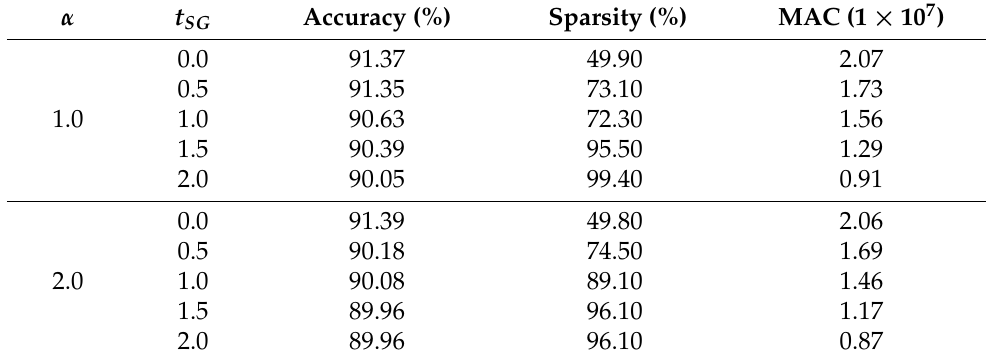
Table 7. Effectiveness of CSGN (SG) according to the hyperparameters with baseline